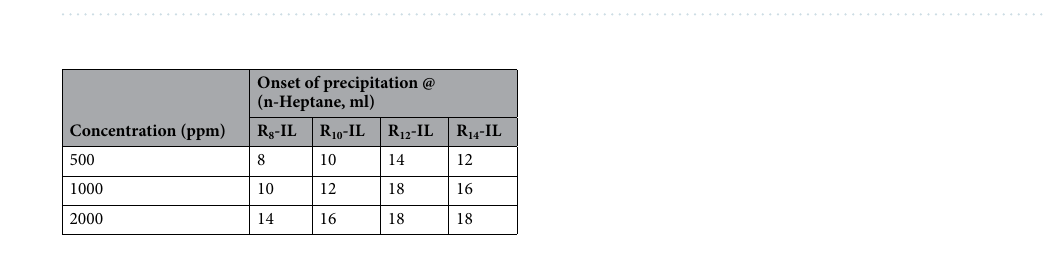
Figure 7. Effect of the prepared dispersants (R 8 -IL, R 10 -IL, R 12 -IL, and R 14 -IL) on the asphaltene onset precipitation.